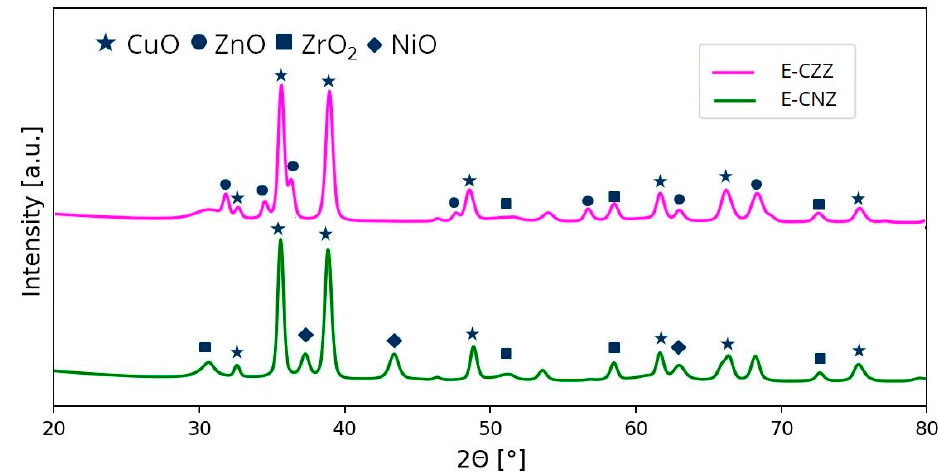
Figure 1. X-ray di ff raction pattern of the calcined samples. Figure 1. X-ray diffraction pattern of the calcined samples.